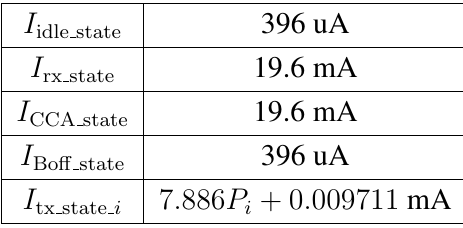
Table 1. Current consumption in each state for a generic CC2420 radio